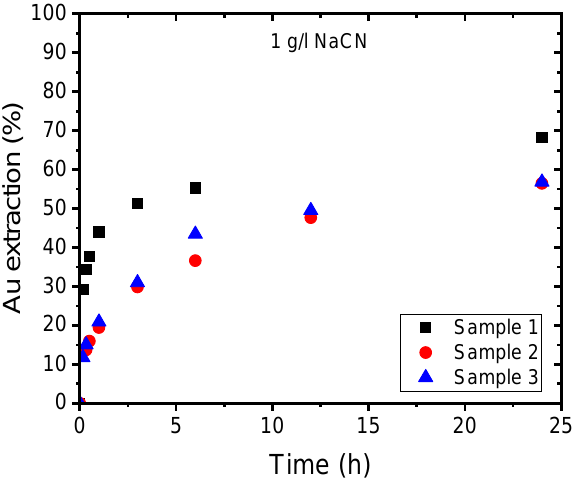
Figure 7. Au extraction at 1 g/L NaCN (30% solids, −300 + 150 µm PSD, 300 rpm, 26 °C).